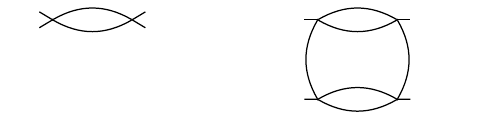
Figure 3 . Two Feynman diagrams obtained from the two 4-colored graphs of (cid:12)gure 2 by shrinking the colored edges. Half-edges are also added to keep track of the external